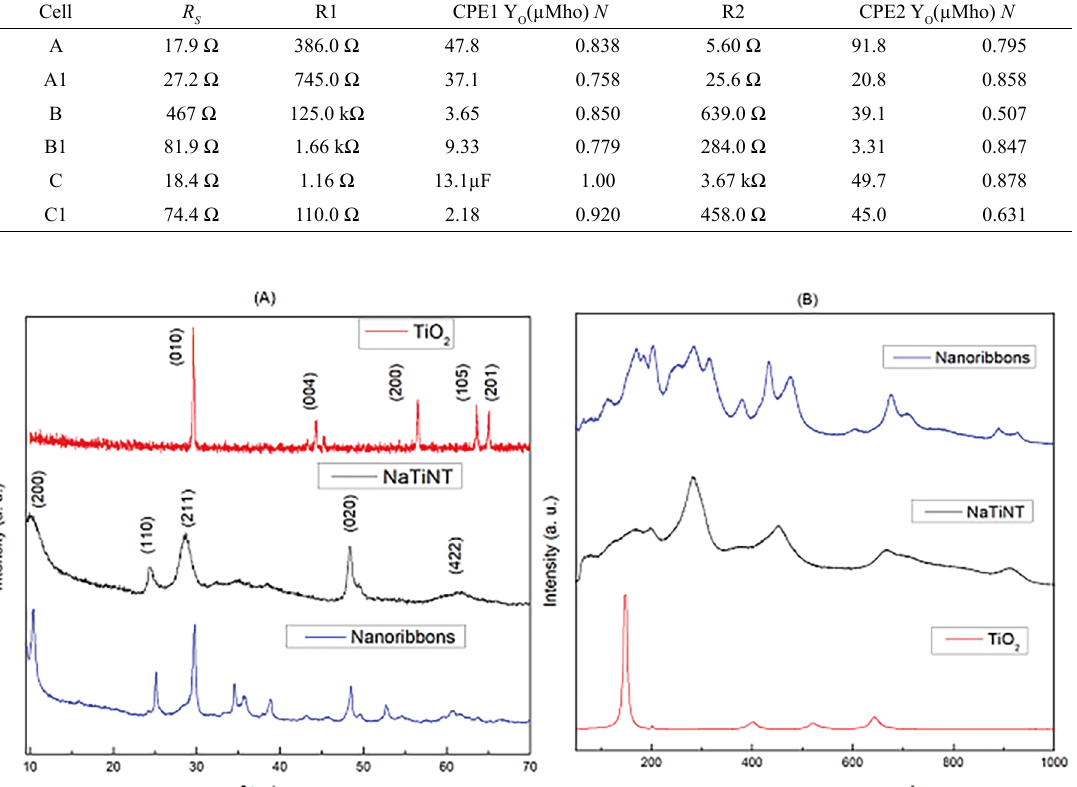
Figure 1. (A) XRD patterns of the TiO powders samples.